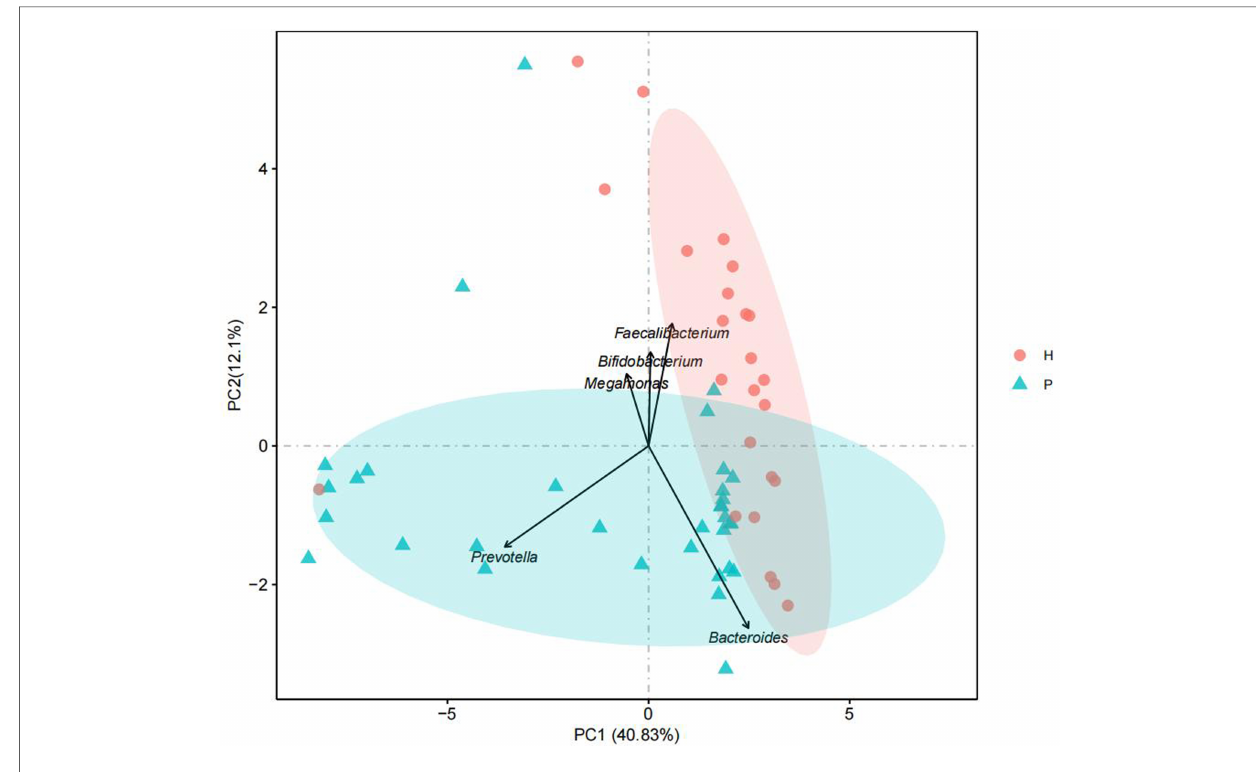
FIGURE 2 Principal component analysis.